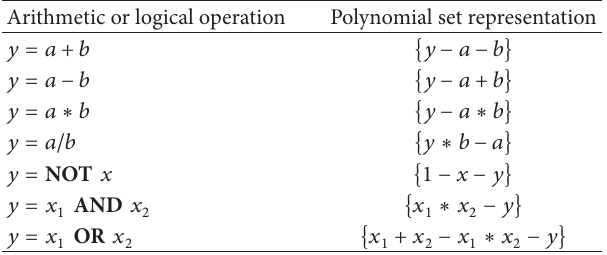
Table 1: Polynomial representation for arithmetic and logical